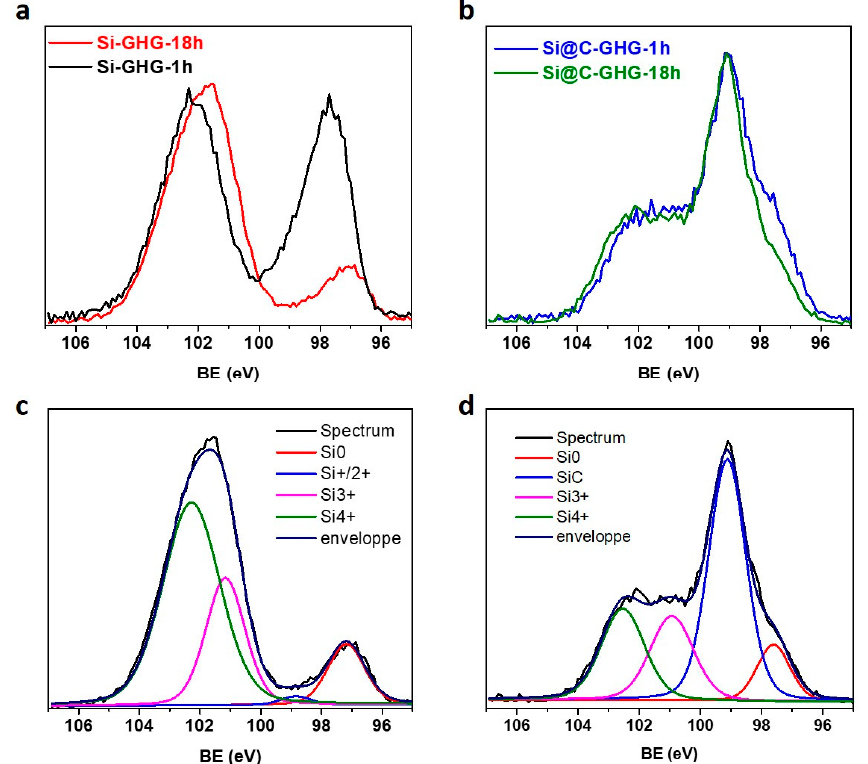
Figure 5. XPS spectra of the four samples. XPS Si 2p HR spectra for Si-GHG-1h and Si-GHG-18h ( a ) and XPS Si 2p HR spectra for Si-GHG-18h and Si@C-GHG-18h ( b ). Deconvolutions of the HR Si 2p XPS spectra were recorded for Si-GHG ( c ) and Si@C-GHG ( d ) after 18 h of reaction. Table 2. Inter-graphene sheets distance—d—determined from XRD, C/O ratios calculated from XPS atomic concentration data, and electrical conductivities recorded for Si-GHG 1 h and 18 h compared to that of Si@C-GHG 1 h and 18 h. Densities of Si-GHG-18h and Si@C-GHG-18h are reminded.